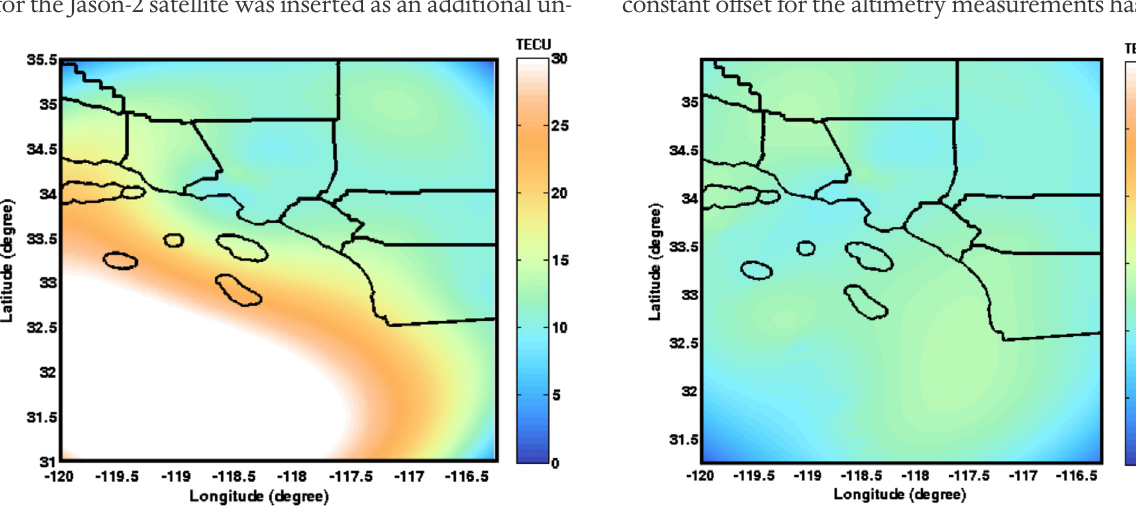
Figure 4. 3-D VTEC model result for August 25, 2012, 70:45:00 (UT) for j = 4, RMSE = 0.10 TECU.